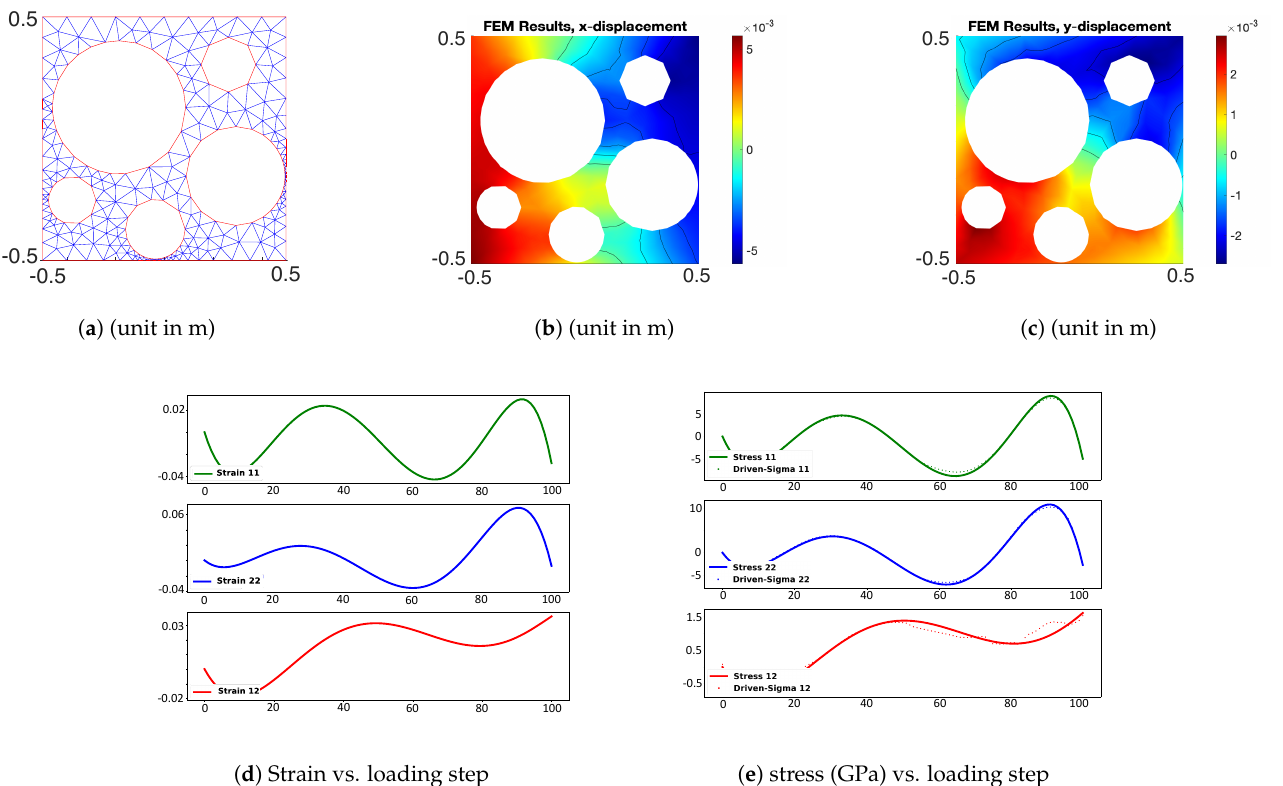
Figure 9. Test 3 for homogenization of linear elastic microstructure ( µ = 55 GPa and λ = 200 GPa), ( a ) FEM mesh, ( b ) X displacement (initial step), ( c ) Y displacement (initial step), ( d ) randomly generated strain, and ( e ) comparison of the homogenized effective stress and the data-driven responses.